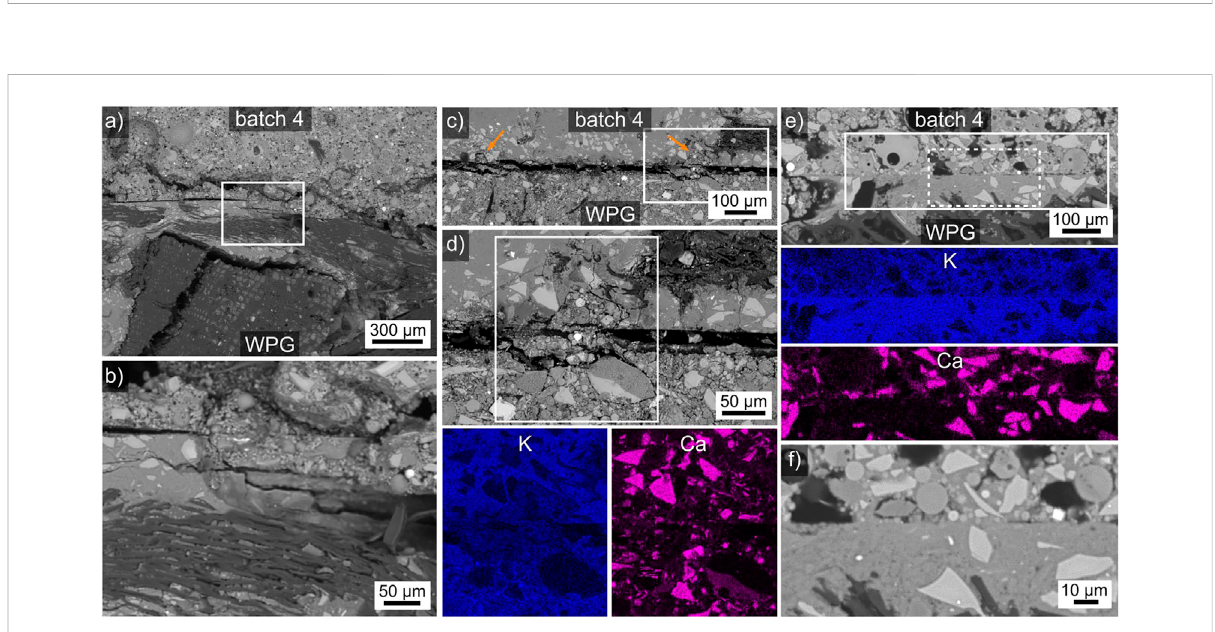
FIGURE 6 (A) SEMmicrographofthebatch4/WPGmatrixinterface,theframedareaispresentedingreaterdetail,see (B) . (C) SEMmicrographofacracked batch 12/WPG matrix interface, orange arrows highlight locations of mechanical interlock. The framed area is presented in greater detail in (D) , selected EDXS maps of this framed area are presented below. (E) SEM micrograph of a batch 12/WPG matrix interface, selected EDXS maps of the solid framed area are presented below. The area in the dashed framed is presented in the SEM micrograph (F) for greater